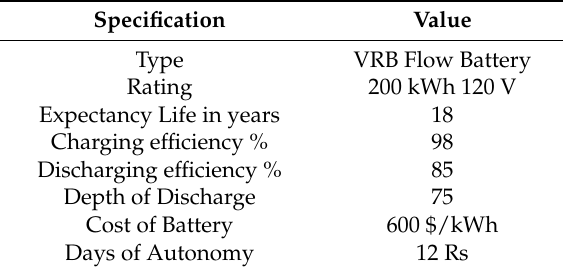
Table 4. Specification of Vanadium Redox Battery (VRB) battery.